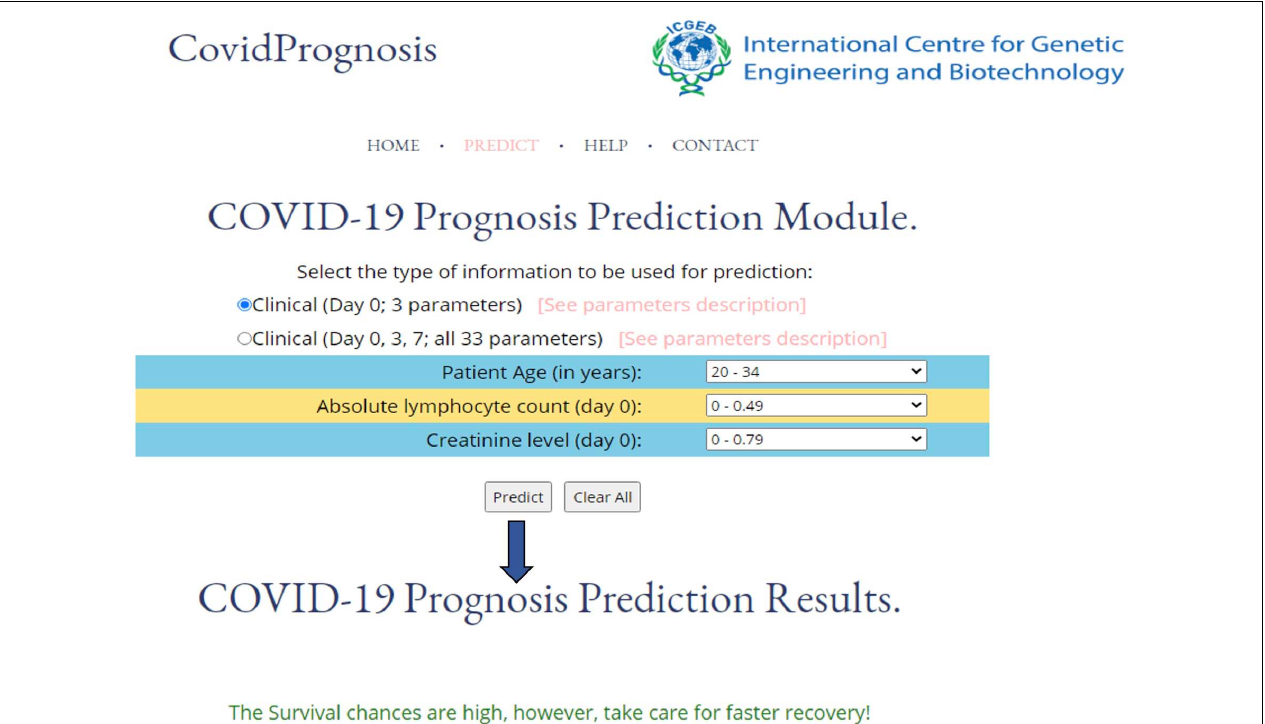
FIGURE 4 | A screenshot showing the functionality of the CovidPrognosis webserver with three clinical parameters for Day